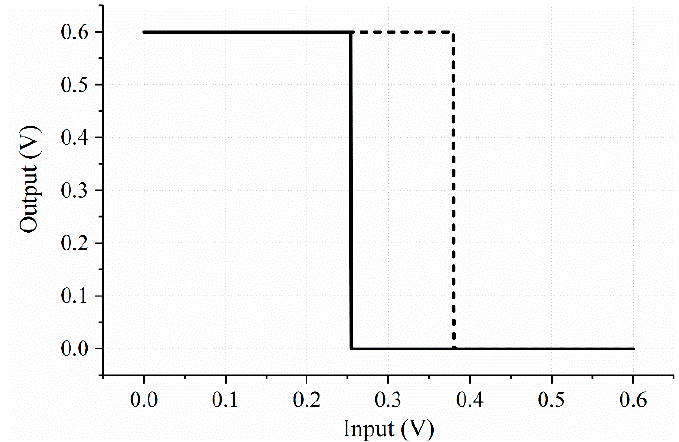
Figure 7. Voltage transfer characteristics of the proposed Schmitt trigger. Vin + is swept from 0 to 0.6 V and vice versa, while Vin − is set to 0.3 V, and V B1 and V B2 are 0.35 V and 0.3 V, respectively.